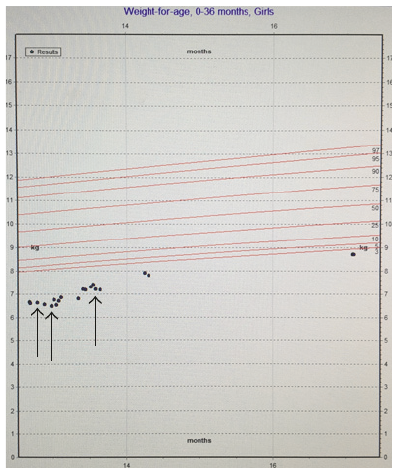
Figure 4: Patient’s growth chart—weight for age. Arrows from left to right. (1) Initiation of nasogastric tube feeds. (2) Initiation of antiviral therapy. (3) Gastrostomy tube